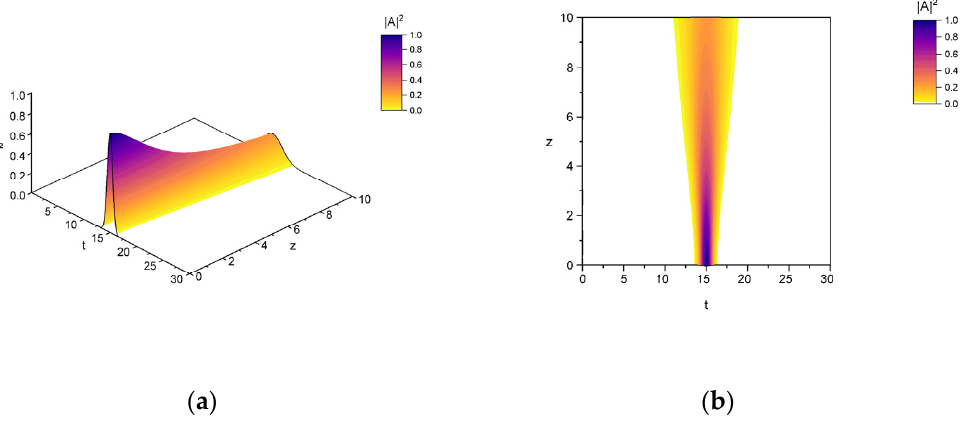
( a ) ( b ) Figure 8. Evolution of the intensity 2 | | A depicted in 3D view ( a ), and on the ( t,z ) plane ( b ) and Figure 8. Evolution of the intensity | A | 2 depicted in 3D view ( a ), and on the ( t,z ) plane ( b ) and computed for the pulse propagation in a linear medium α = 0, δ = computed for the pulse propagation in a linear medium 0, 0 α δ= = .